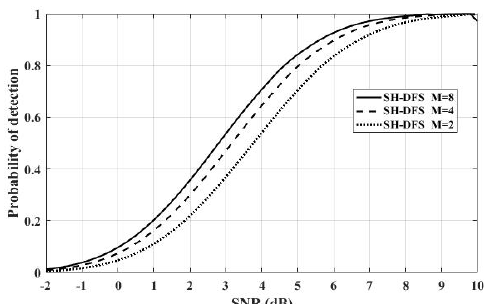
Figure 9. The probability of detection of the clustered distributed system with SH-DFS at a different number of local sensors versus SNR.